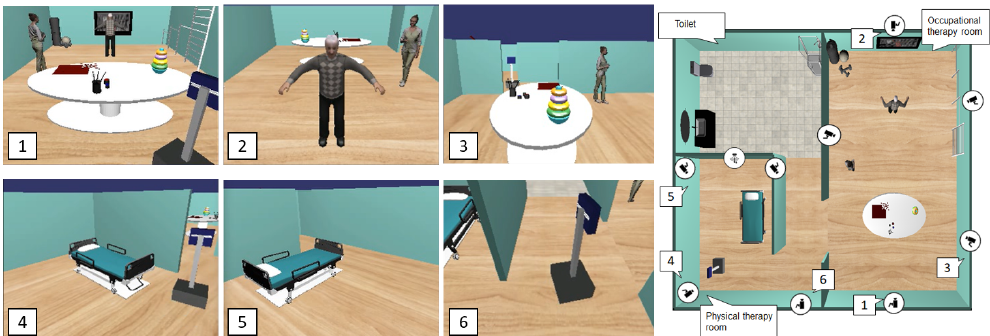
Figure 12. Six RGB images acquired by the caregiving center’s sensor network in different moments. The cameras are tagged to locate them in the environment used for the experiments.